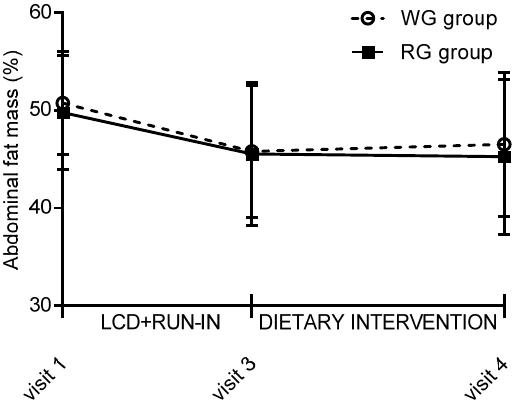
Figure 4. Mean abdominal fat mass percentage with SD during the LCD and run ‐ in phases (visit